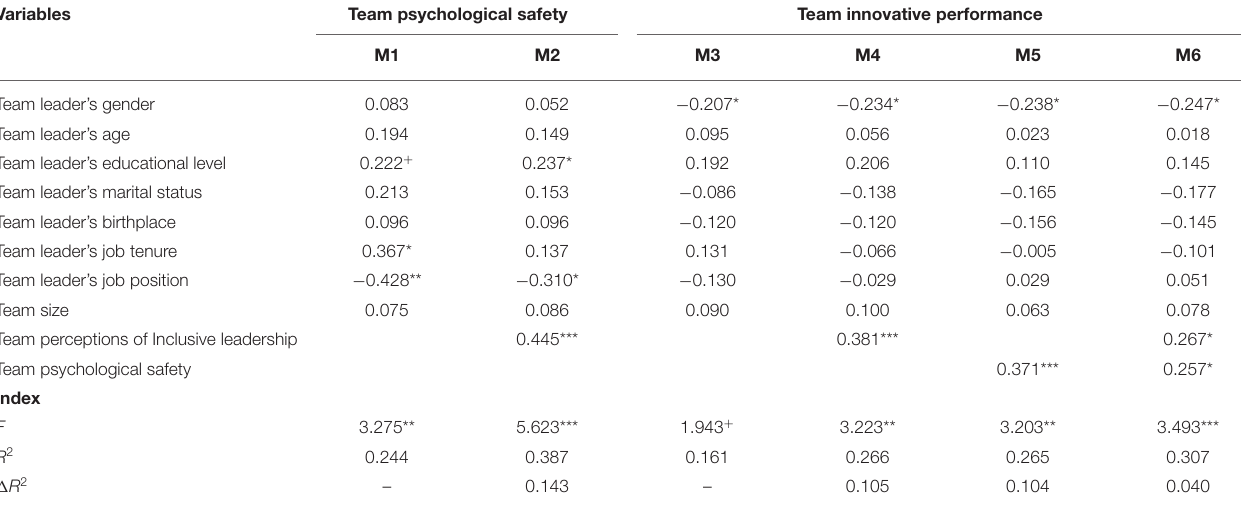
TABLE 6 | Results of hypotheses testing at the team level.